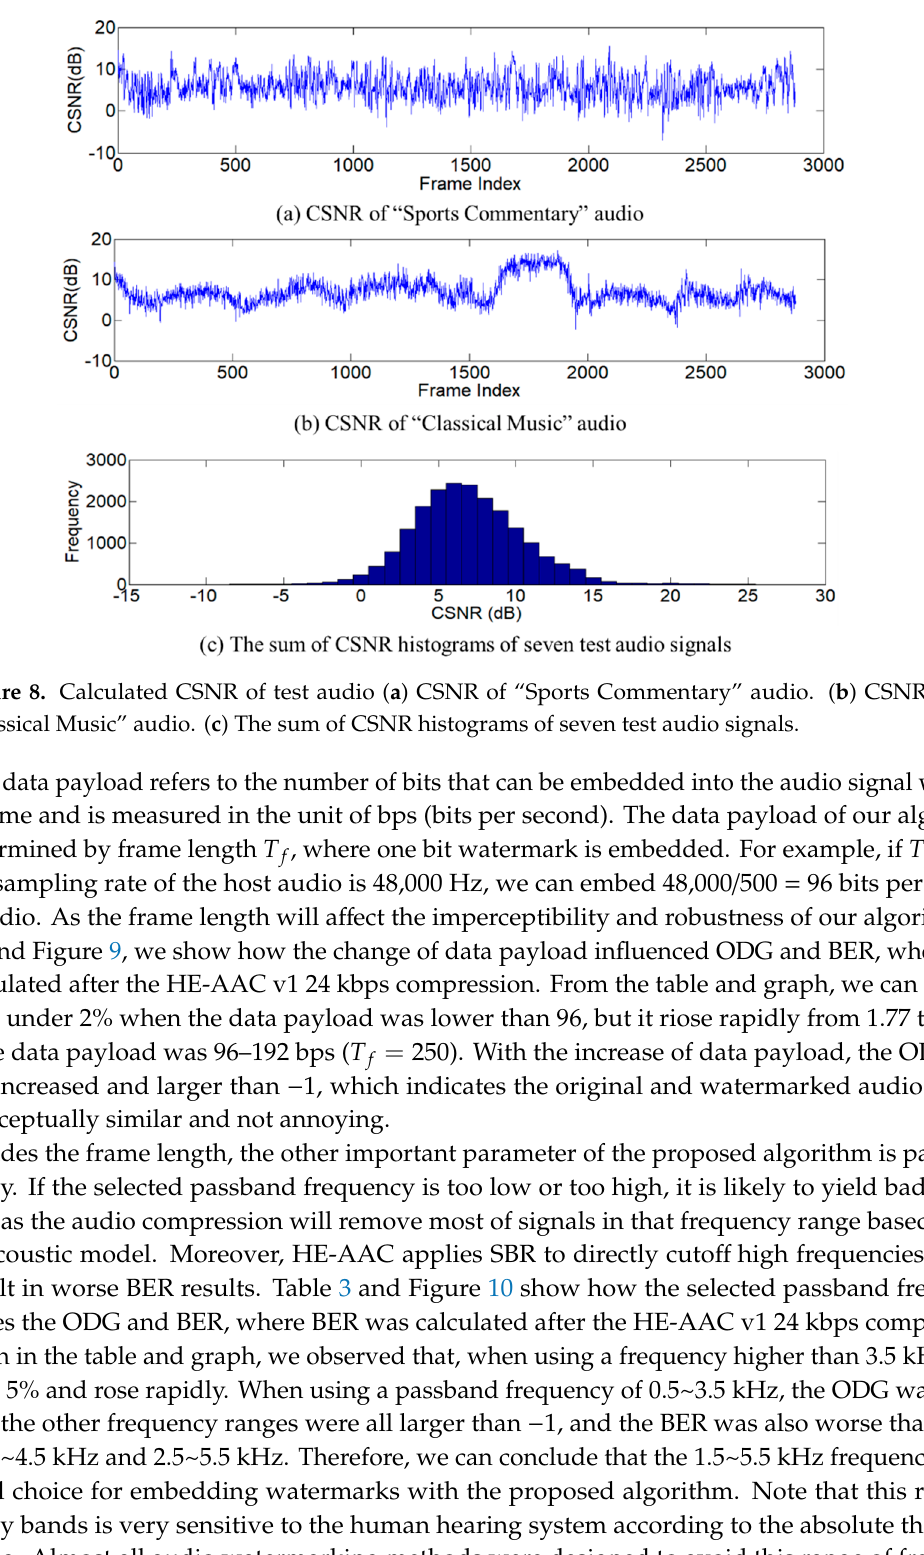
Table 2. ODG and bit error rate (BER) values under various data payloads. Data Payload (bps) ODG BER (%)